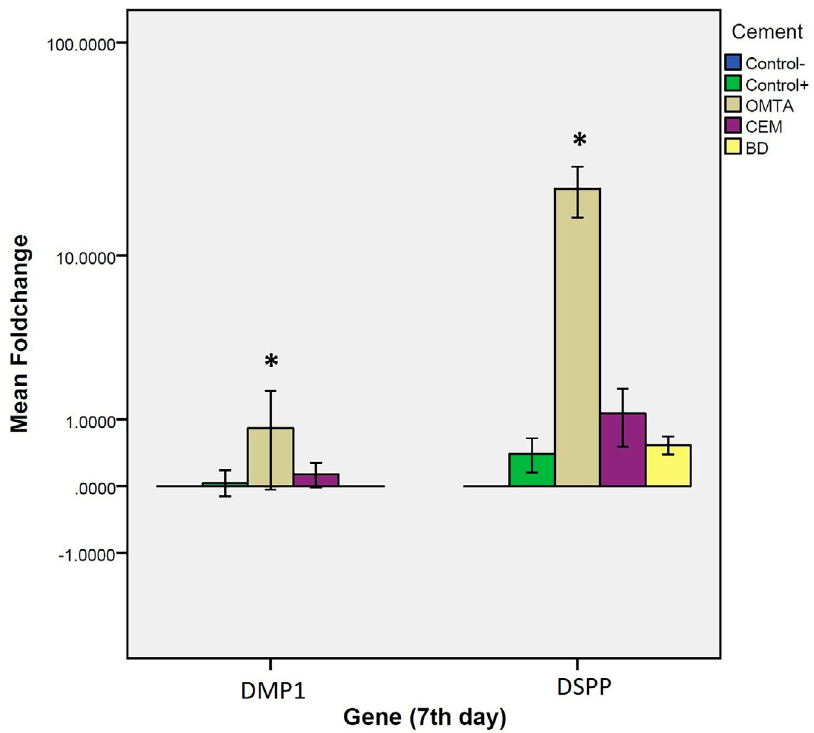
Figure 5- Real-time PCR test results comparing gene expression of DSPP and DMP1 induced by the test materials on day seven. One- way ANOVA revealed a statistically significant difference in expression of DSPP and DMP1 genes between test materials on day seven. Complementary Tukey HSD test revealed that OMTA significantly increase expression of the aforementioned genes (p=0.0002)